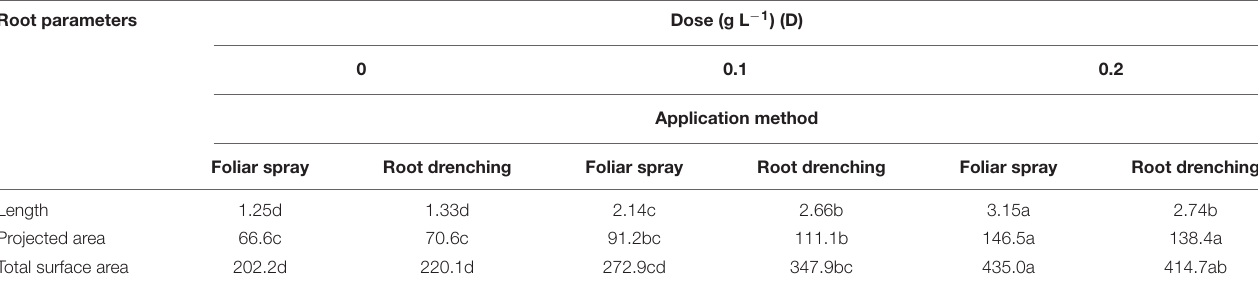
TABLE 3 | Dose × method interaction of animal-derived PH biostimulant on root length (m × 10 3 /plant), projected area (cm 2 /plant), total surface area (cm 2 /plant) in petunia plants for doses D0, D0.1, and D0.2, and foliar spray and root drench application methods. Root